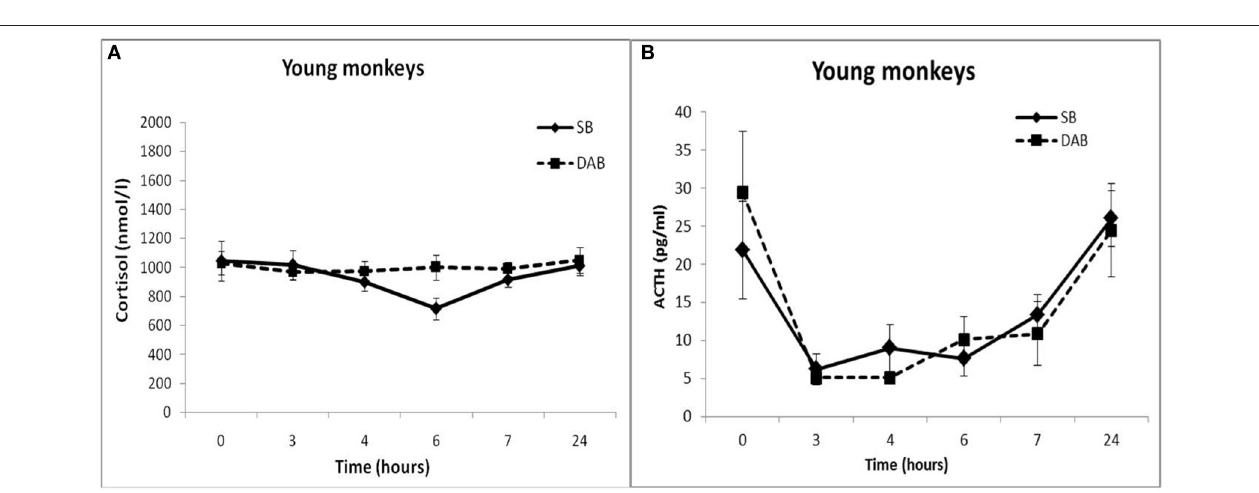
FIGURE 2 | Dynamics of CORT (A) and ACTH (B) concentrations in peripheral blood plasma of young female rhesus monkeys with SB and DAB in response to administration of placebo (mean ± S.E.M).